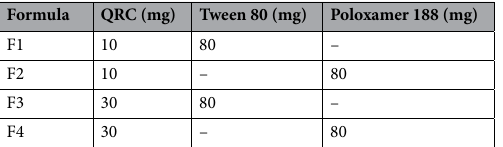
Table 1. Different polymeric nanocapsules formulations prepared.